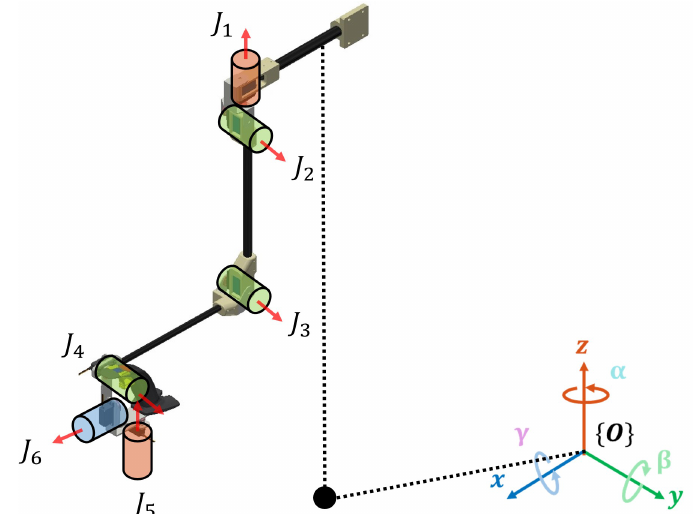
Figure 5. The prototype of the K-handler.